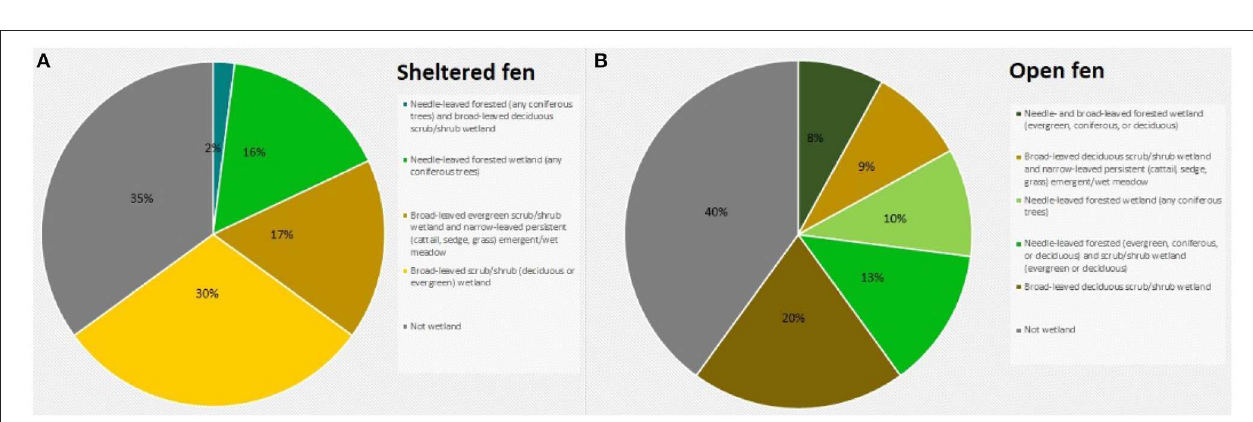
FIGURE 1 | Pins represent tower location. Scales for each site are located at the bottom right of each aerial photo. Circles indicate flux footprints. (A) Aerial imagery of sheltered fen US-ALQ ( Google earth V 7.3.2.5776, 2016a). Radius: 238m. (B) Aerial imagery of open fen US-Los (Google earth V 7.3.2.5776, 2016b). Radius: